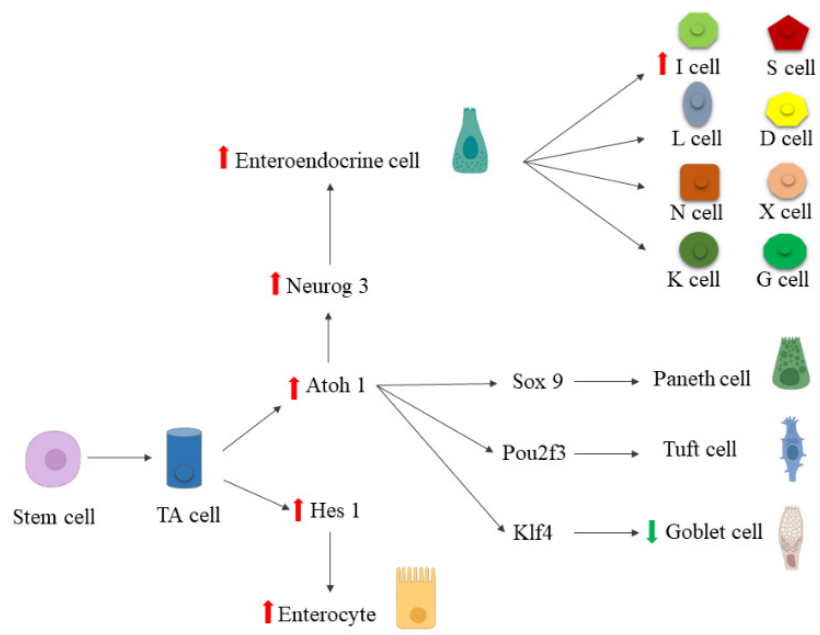
Figure 11. Schematic representation of palmitate effect on the expression of TFs regulating intestinal cell differentiation. Red arrows represent upregulated transcripts. The green arrow represents the downregulated transcript.